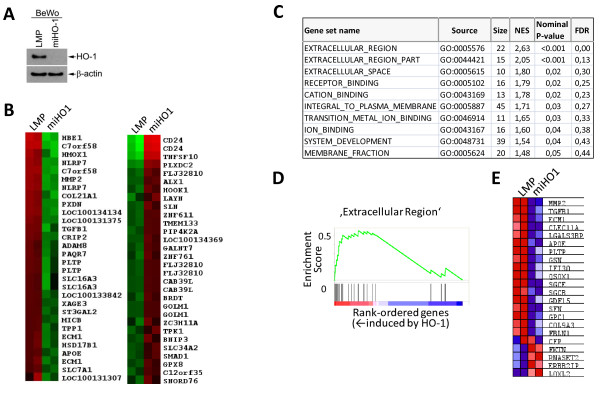
The HO-1 gene signature in BeWo cancer cells. (A) Western blot analysis of ctrl (LMP) or HO-1 shRNAmir-transduced BeWo cells (miHO-1) demonstrates efficient HO-1 knock-down. β-actin indicates equal loading. A representative example is shown. (B) A heat map of top 30 genes that discriminate HO-1 expressing (LMP) from HO-1 knockdown (miHO-1) cells as judged by LIMMA analysis (p < 0.05). Downregulated genes are shown in green and upregulated genes in red. Note that some genes are represented by multiple probe sets on the GeneChip. (C) Pathways enriched in HO-1 expressing BeWo cells. The number of genes contained within one pathway/gene set is given by 'Size'. Normalized enrichment score ('NES') is calculated by the GSEA software. Statistical significance is indicated by the nominal P-value ('NOMp-val') and the error is controlled by the false discover rate ('FDR q-val'). (D) Distribution of 20 pathway molecules for the top-ranking gene set amid the total ranked list of all transcripts analyzed by GSEA. Genes were rank ordered based on differential expression between LMP and miHO1 BeWo cells. (E) Corresponding heatmap showing relative expression of the 'Extracellular Region' pathway gene members in LMP and miHO-1 BeWo cells. Downregulated genes are shown in blue and upregulated genes in red.